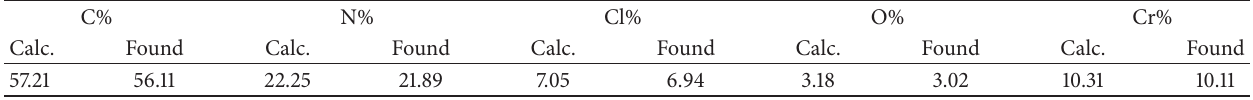
Table 2: The XPS elemental analysis of poly-o-phenylenediamine (POPDA). C% N% Cl% O% Cr% Calc. Found Calc. Found Calc. Found Calc. Found Calc. Found 57.21 56.11